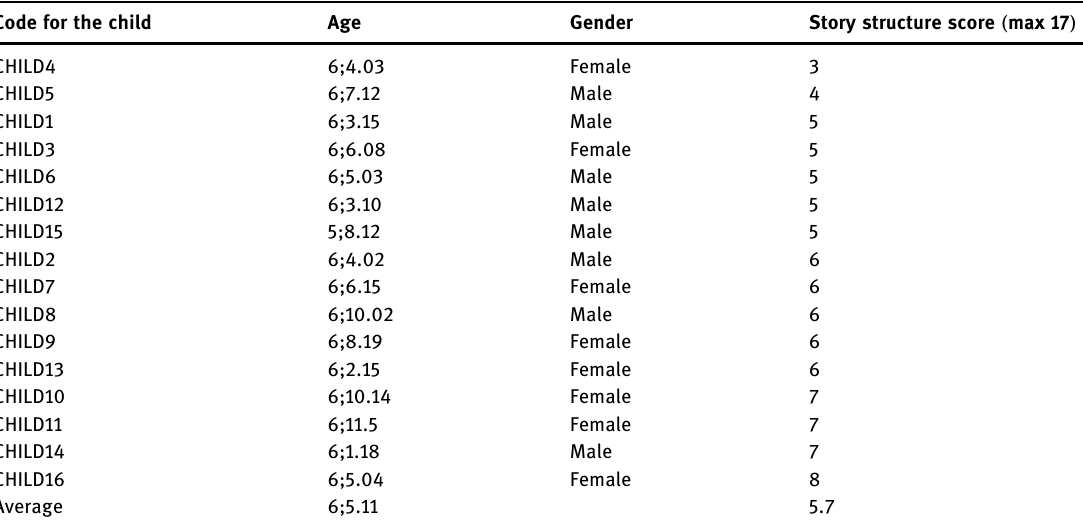
Table 1: Overview of participants and scores for narratives produced Code for the